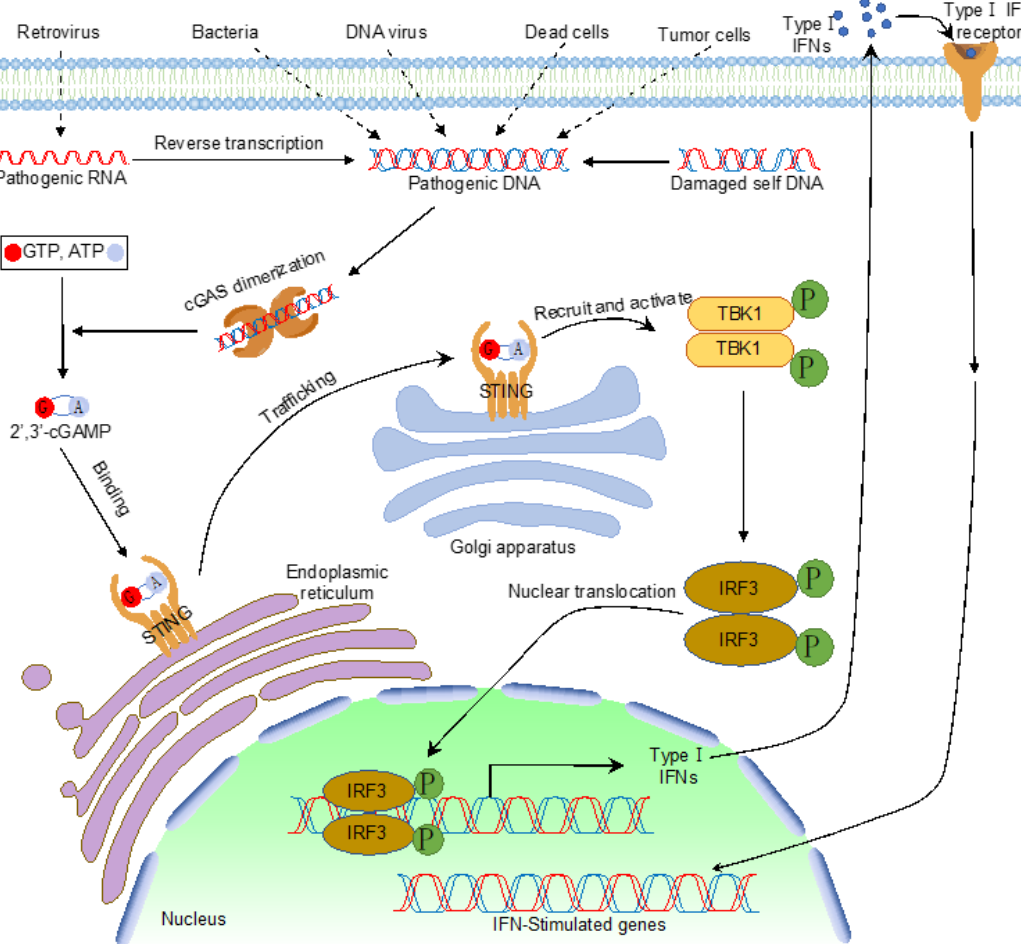
Figure 1. The cytosolic DNA sensing pathway mediated by cyclic GMP–AMP synthase (cGAS). It has not been reported that cGAS can discriminate pathogenic and host DNA, i.e., the preference for DNA sequence and modification has yet to be found. Excessive host DNA activates the cGAS lupus erythematosus (SLE). Therefore, cells must keep cGAS silent from host genomic DNA and, paradoxically, at the same time, cells need to keep cGAS agile to foreign DNA. The old paradigm is that host DNA normally is restricted to cellular compartments, such as the nucleus and the